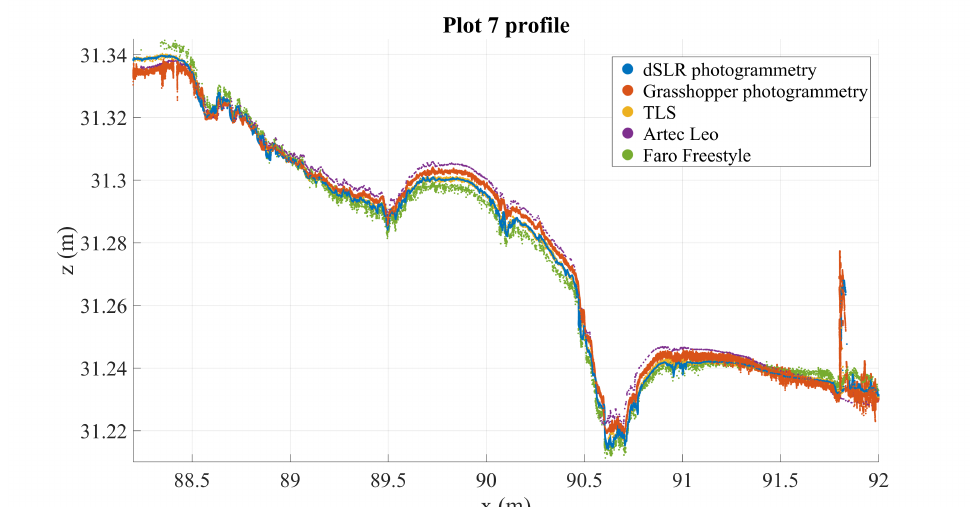
Figure 7. Three mm deep profiles of plot 7 as measured by all instruments in an arbitrary coordinate system.